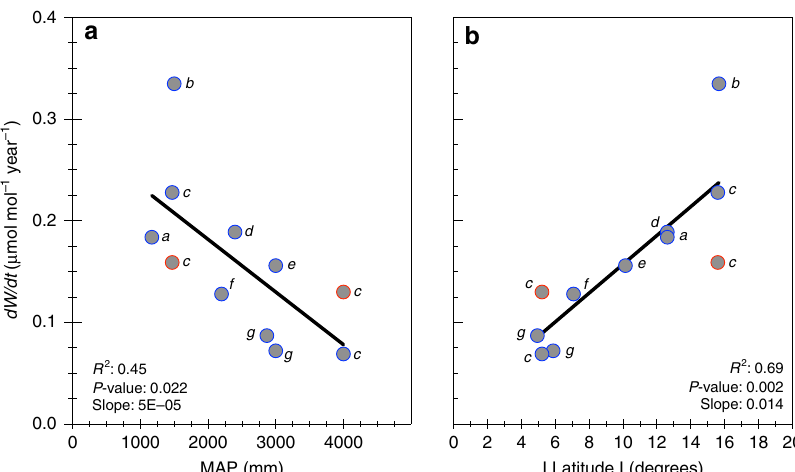
Fig. 2 Rainfall and latitude in fl uences on change in W per unit time. The relationship of dW / dt (change in intrinsic water-use ef fi ciency ( W ) per year; as derived from tree rings) and mean annual precipitation ( a ), and absolute latitude ( b ). The data are site averages of long-term isotope series (each spanning at least the period 1915 – 1995) for tropical biomes. Points marked in red in both ( a ) and ( b ) are legumes. For both ( a ) and ( b ), data sources are: (a) Wils et al. 24 , (b) Nock et al. 27 , (c) van der Sleen et al. 23 , (d) Ballantyne et al. 25 , (e) Hietz et al. 29 , (f) Schollaen et al. 28 , (g) Loader et al.